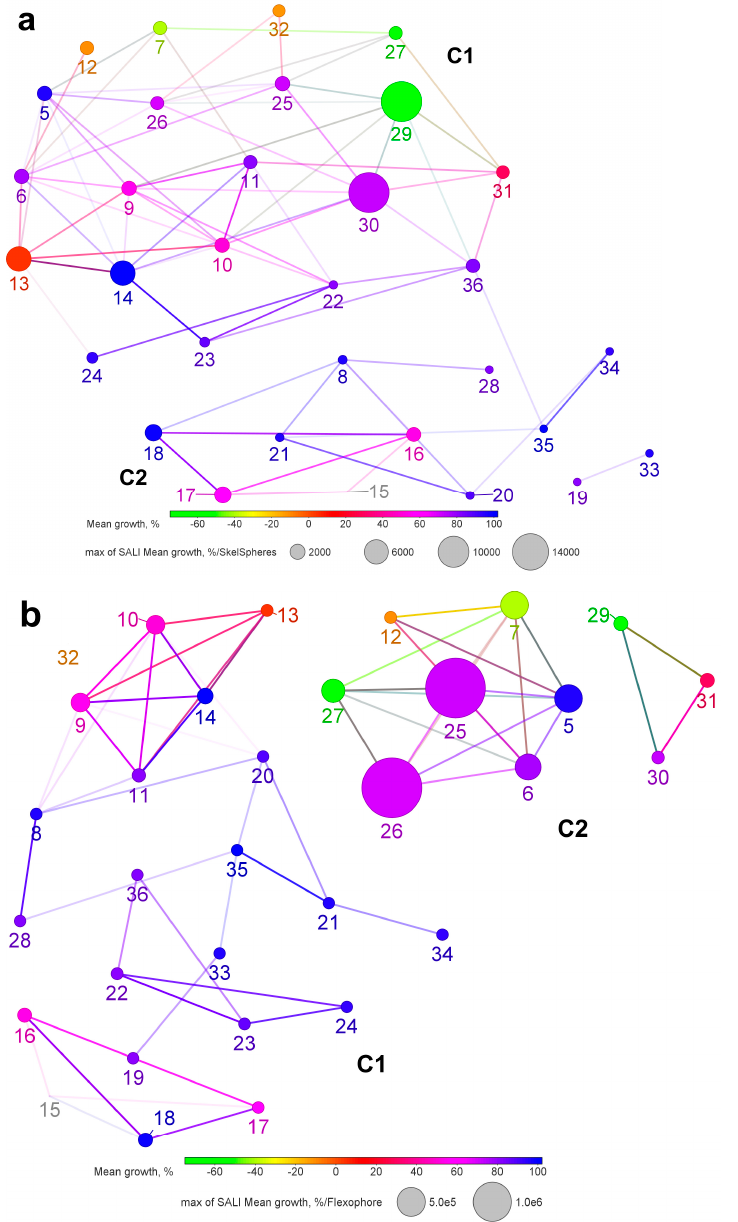
Figure 7. Network-like similarity graphs generated with SkelSpheres ( a ) and Flexophore ( b ) descriptors. Compounds are displayed as nodes and edges indicate molecular similarity relationships. Nodes are colored according to compound cytotoxicity using a continuous color spectrum from green (highest potency in the data set) over red to blue (lowest potency). Nodes are scaled in size according to their contribution to local SAR discontinuity.